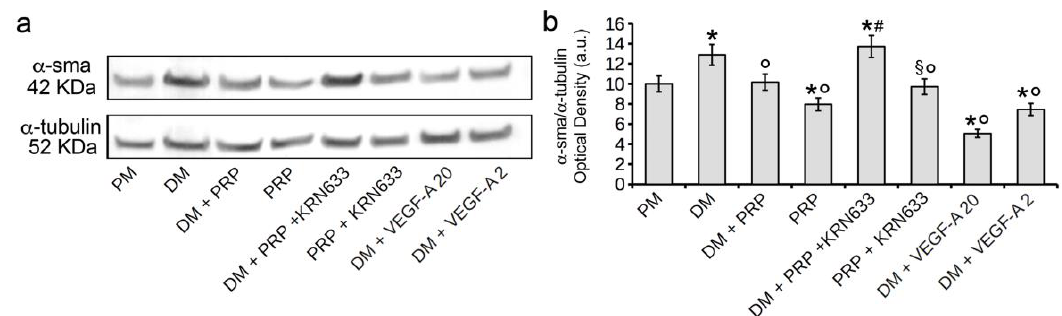
Figure 6. Effect of VEGFR-1 inhibition and of stimulation with soluble VEGF-A on α -sma expression: western blotting analysis. NIH/3T3 fibroblastic cells were cultured in differentiation medium (DM, low serum medium plus 2 ng/mL TGF- β 1) in the absence or presence of 1:50 diluted PRP (DM + PRP) or in the presence of 1:50 serum-free medium diluted PRP (PRP). To evaluate the involvement of VEGF-A/VEGFR-mediated signaling in PRP- induced fibroblast response, the cells were treated with the selective pharmacological VEGFR inhibitor, KRN633 (DM + PRP + KRN633; PRP + KRN633). In parallel experiments the cells were cultured in DM in the presence of two different concentrations of soluble VEGF-A (20 ng/mL, DM + VEGF-A 20; 2 ng/mL, DM + VEGF-A 2). Cells cultured in proliferation medium (PM) served as control undifferentiated cells. ( a ) Representative western blots of α -sma and tubulin expression. ( b ) Histogram showing the densitometric analysis of the bands normalized to α -tubulin. ( b ) Data shown are mean ± S.E.M. and represent the results of at least three independent experiments performed in triplicate. Significance of difference: * p < 0.05 vs. PM; ◦ p < 0.05 vs. DM; # p < 0.05 vs. DM + PRP; § p < 0.05 vs. PRP.